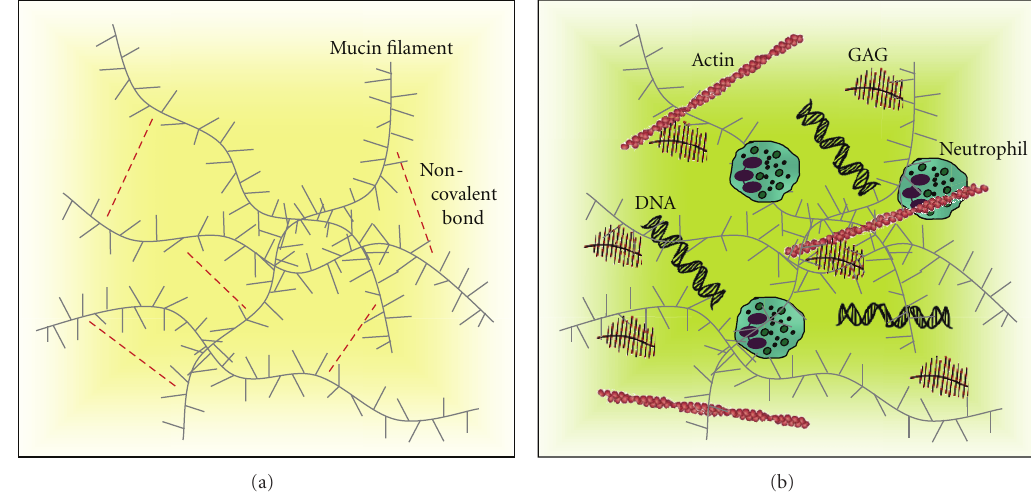
Figure 2: Mucus properties in the CF lung. (a) Mucus in a healthy lung is made up of a network of mucin filaments consisting of highly glycosylated mucin monomers that are crosslinked by disulphide bonds. Mucin filaments are bound together by noncovalent bonds (red dotted lines) such as van der Waals forces. (b) In the CF airways, mucus viscosity is increased by DNA and actin (red) that are released from necrotic neutrophils and aggregate into bundles. Glycosaminoglycans (GAGs, depicted in brown) which are important for regulation of cell interactions have been found to be upregulated and altered in CF. Adapted from Rogers (2007) [26].